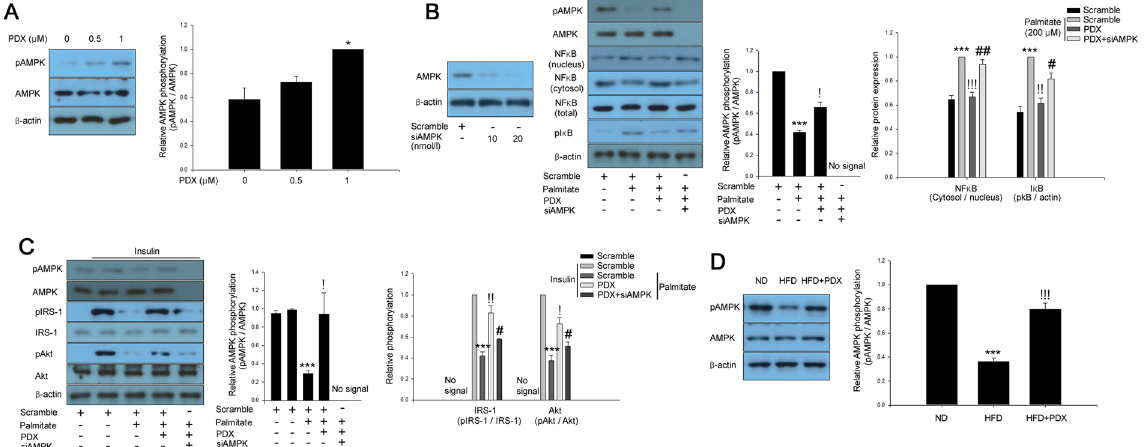
Figure 4. PDX attenuates inflammation and insulin resistance via an AMPK-dependent pathway. ( A ) Western blot analysis of AMPK phosphorylation in differentiated C2C12 cells (0–1 μ M) for 24 hr. ( B ) Confirmation of AMPK siRNA efficiency differentiated C2C12 cells. Western blot analysis of AMPK phosphorylation and palmitate (200 μ M)-induced inflammation markers in AMPK siRNA (20 nM)-transfected differentiated C2C12 cells treated with PDX (0–1 μ M) for 24 hr. ( C ) Western blot analysis of AMPK phosphorylation and palmitate- induced impairment of IRS-1 and Akt phosphorylation in AMPK siRNA-transfected differentiated C2C12 cells treated with PDX (0–1 μ M) for 24 hr. Human insulin (10 nM) was used to stimulate insulin signaling for 3 min. ( D ) Western blot analysis of AMPK phosphorylation in soleus muscle of mice treated HFD and PDX (five animals per treatment group). Means ± SEM were obtained from three separated experiments or five animals. *** P < 0.001 and * P < 0.05 when compared to the control or the ND treatment. !!! P < 0.001, !! P < 0.01, and ! P < 0.05 when compared to the palmitate or the HFD treatment. ## P < 0.01 and # P < 0.05 when compared to the palmitate plus PDX